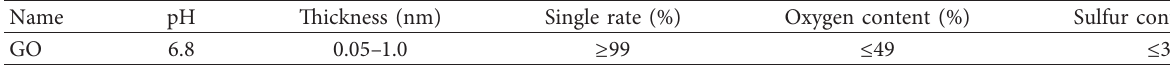
Table 2: Dispersion indices of GO.